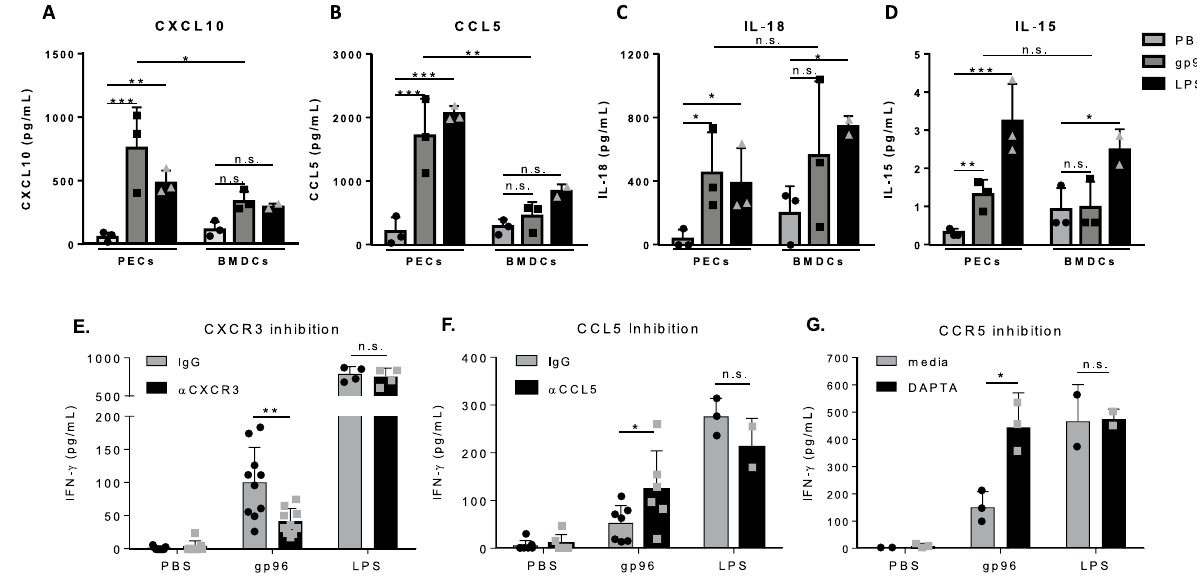
Figure 2. CXCR3 ligands are required for NK cell activation by PECs. ( A–D) One million PECs or BMDCs were incubated with 200 µ g/mL gp96 or 1 µ g LPS for 10 h. Supernatants were harvested and analyzed by Luminex for the secretion of (A) CXCL10 (B) CCL5 (C) IL-18 and (D) IL-15. (E–I) Fifty thousand PECs were plated with 5 × 10 4 NK cells in the presence of 200 µ g/mL gp96 and (E) α -CXCR3 antibody, (F) α -CCL5 antibody, or (G) DAPTA. Supernatant was harvested after 72 h and assayed by IFN- γ ELISA. Data in all panels are pooled from 3 independent experiments. Data are represented as mean ± s.d. ns not significant, *p < 0.05, **p < 0.01, ***p < 0.001 [Two-way ANOVA with Sidak’s multiple comparison test (all panels) and Dunnett’s multiple comparison test